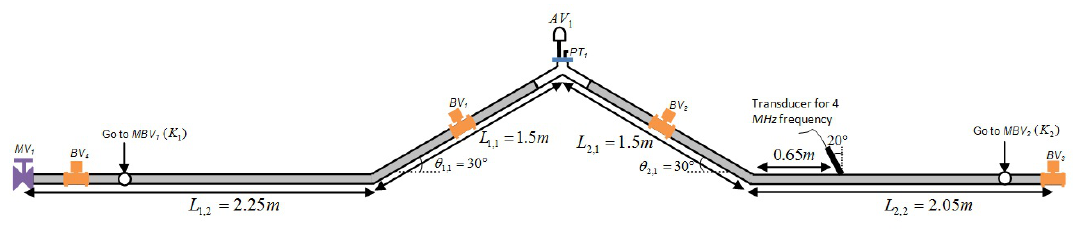
Figure 4. The pipe system and its